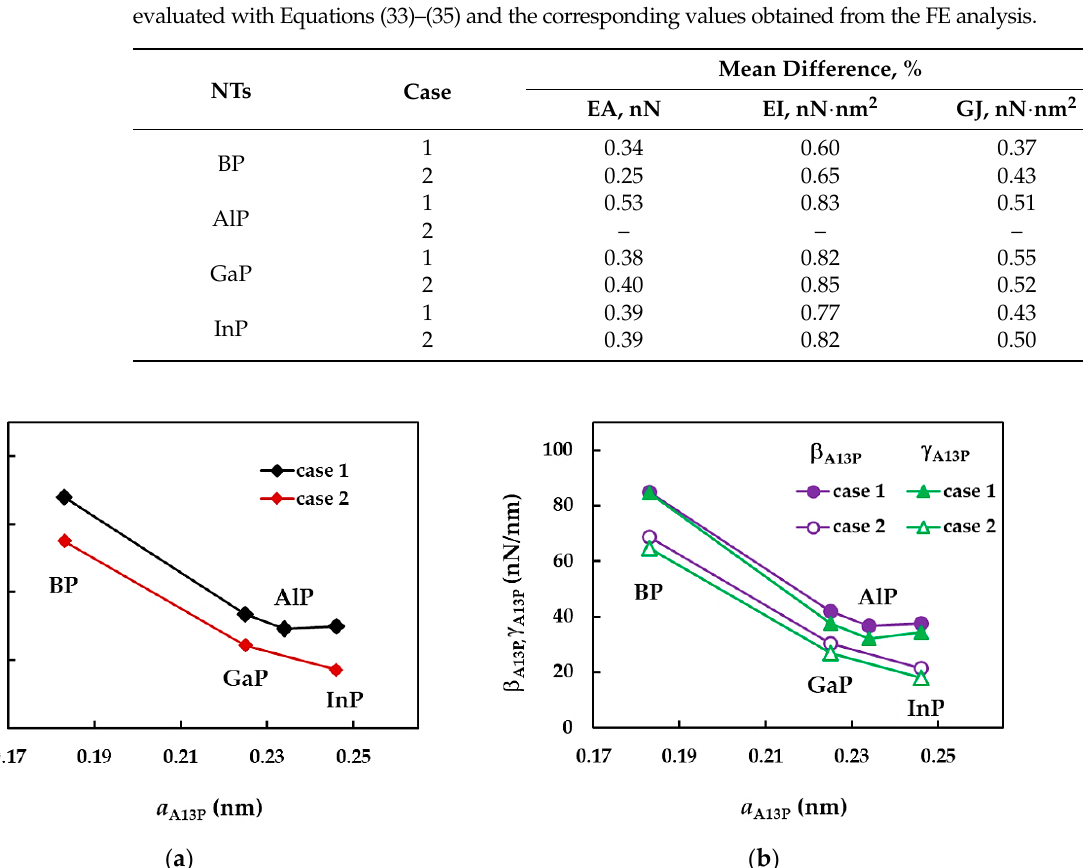
Figure 10. Evolutions of ( a ) α A13P , and ( b ) β A13P and γ A13P fitting parameters with the bond length, a A13-P , for the two cases of input values in the numerical simulation of SWBPNTs, SWAlPNTs, SWGaPNTs and SWInPNTs.